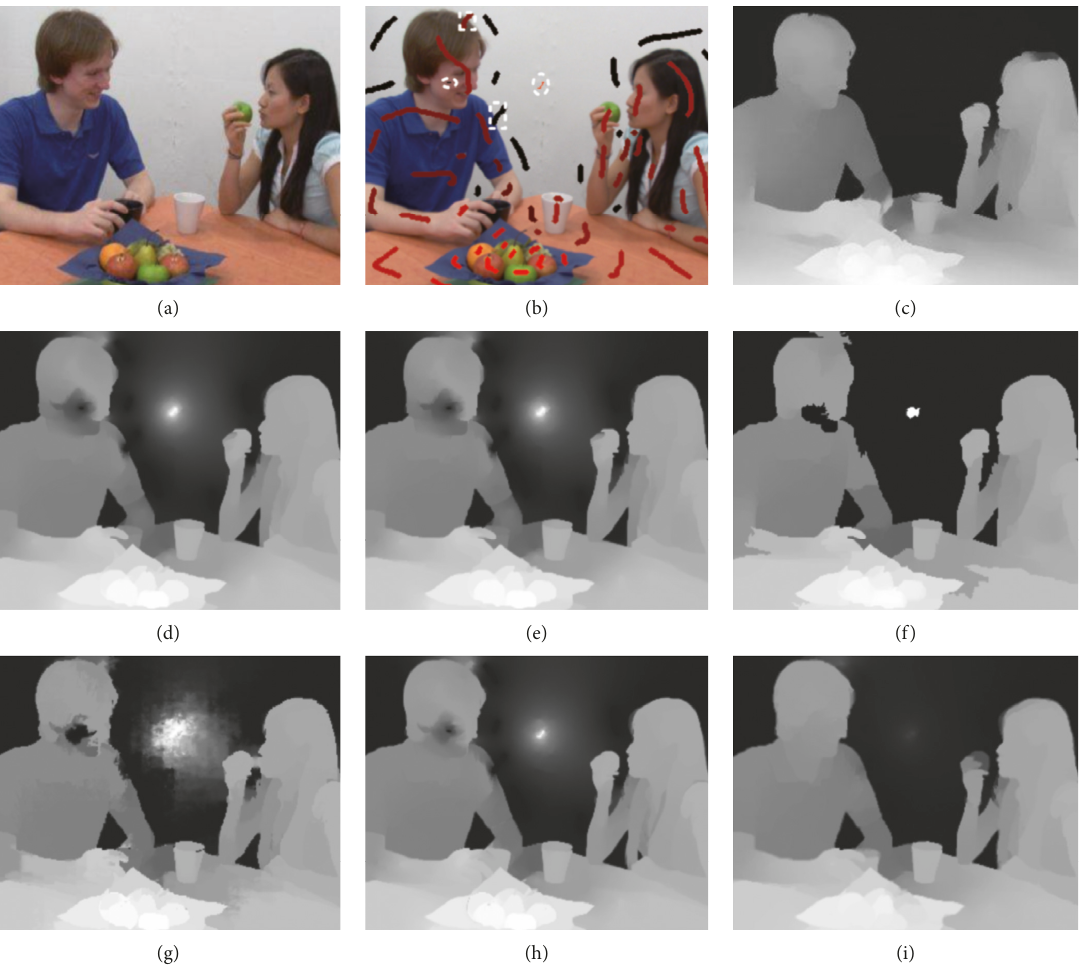
Figure 8: Results for RGBZ_01 in the presence of inaccurate scribbles. (a) Input image. (b) User scribbles. (c) Groundtruth. (d) Depth of RW [4]. (e) Depth of OPT [6]. (f) Depth of HGR [10]. (g) Depth of SOPT [13]. (h) Depth of NRW [14]. (i) Depth of